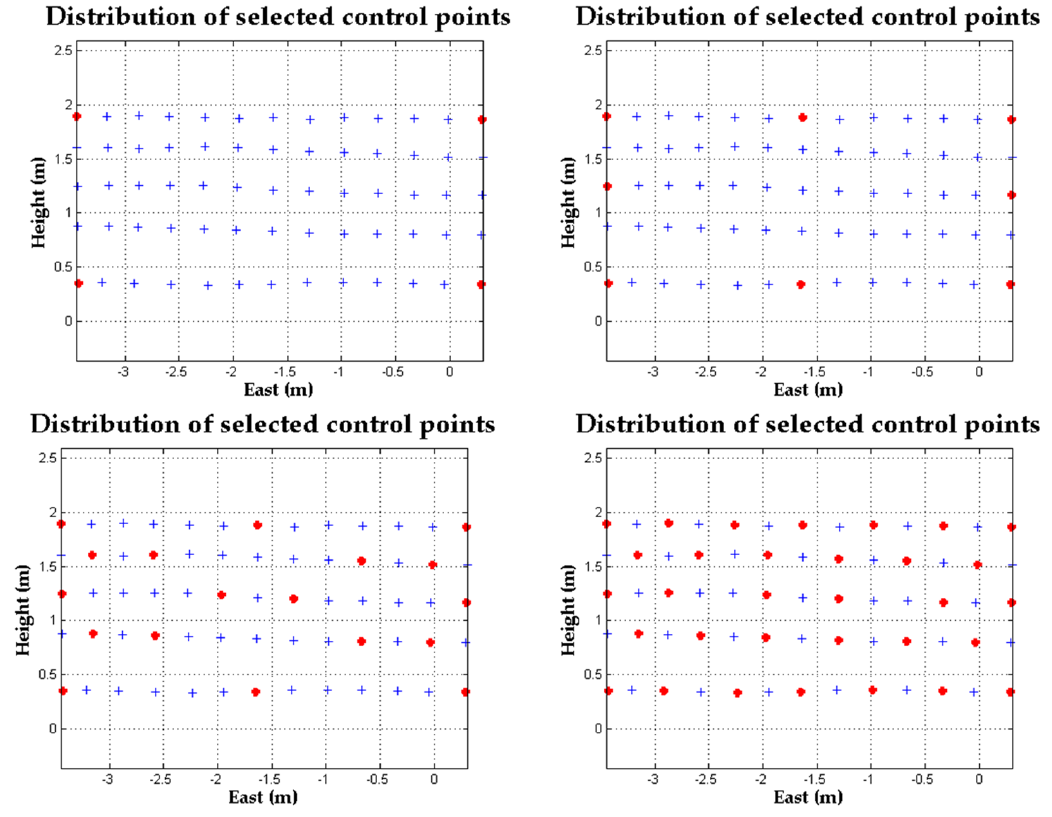
Figure 9. The selected control points of quantity analysis for space resection. Table 4. The position error of quantity analysis for the iPhone 5S.